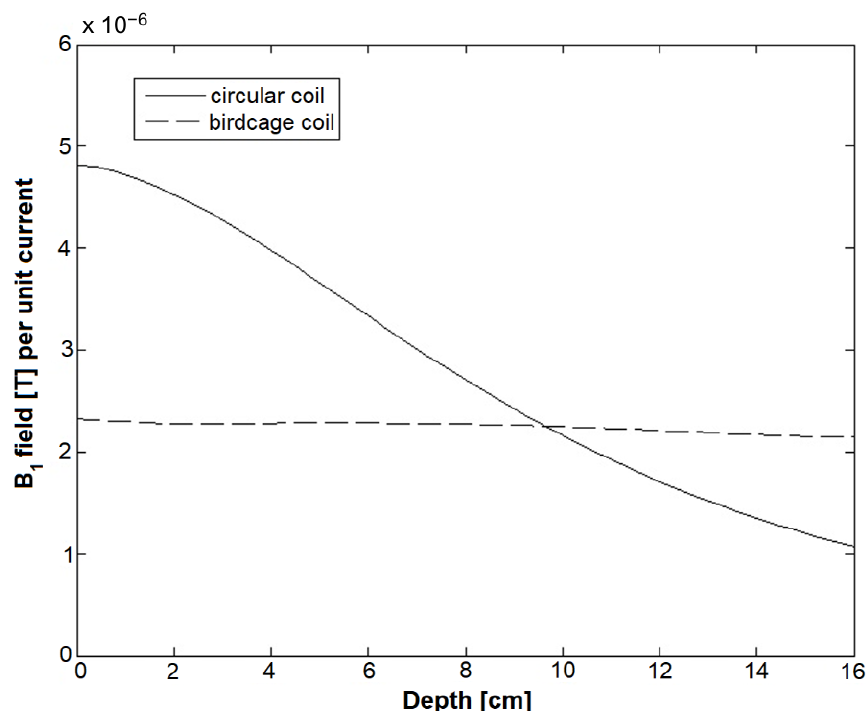
Figure 6. Comparison of the magnetic field patterns for the circular and the birdcage 13 C coils. Adapted by permission from Giovannetti et al., App Magn Reson 2012 [18].